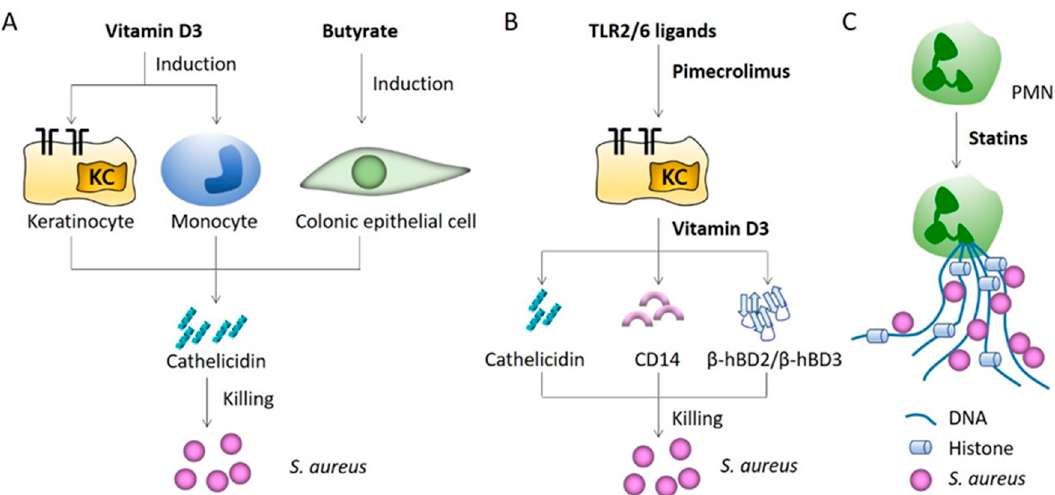
Figure 2. Immune-based strategies antimicrobial peptides and NETs. ( A ) Vitamin D3 induces cathelicidin expression in keratinocytes and monocytes, whereas butyrate induces cathelicidin in colonic epithelia, leading to the enhanced antimicrobial activity against S. aureus. ( B ) Calcineurin inhibitor pimecrolimus enhances expression of cathelicidin, CD14, and human β -defensin-2 and β -defensin-3 in response to TLR2/6 ligands in keratinocytes and leads to inhibition of S. aureus growth. Pimocrolimus function can be enhanced by 1,25(OH)2 vitamin D3. ( C ) Statins enhance S. aureus clearance using antibacterial DNA-based extracellular traps in human and murine myeloid cells, by targeting the sterol biosynthesis pathway. KC: keratinocytes-derived chemokine; PMN: polymorphonuclear